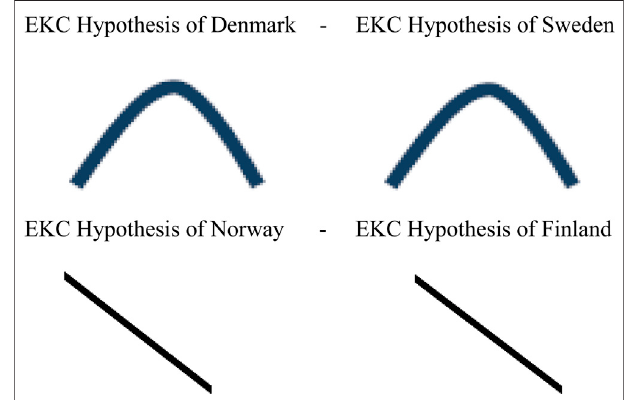
FIGURE 2 | EKC hypothesis of Scandinavian